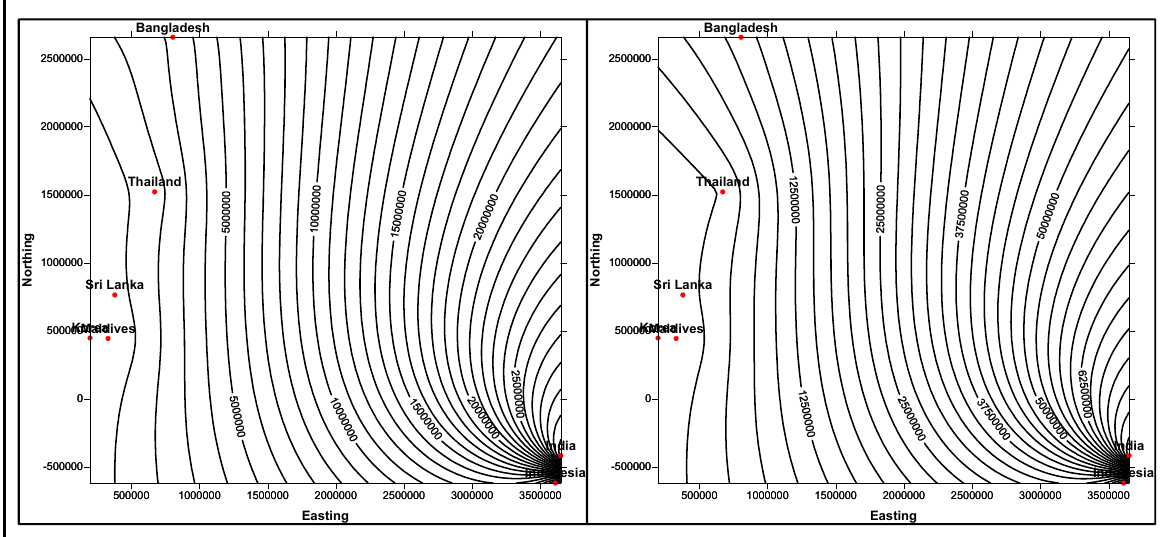
Figure 21. Map view showing diabetes reporting for SE Asia region (for years 2000 and 2030